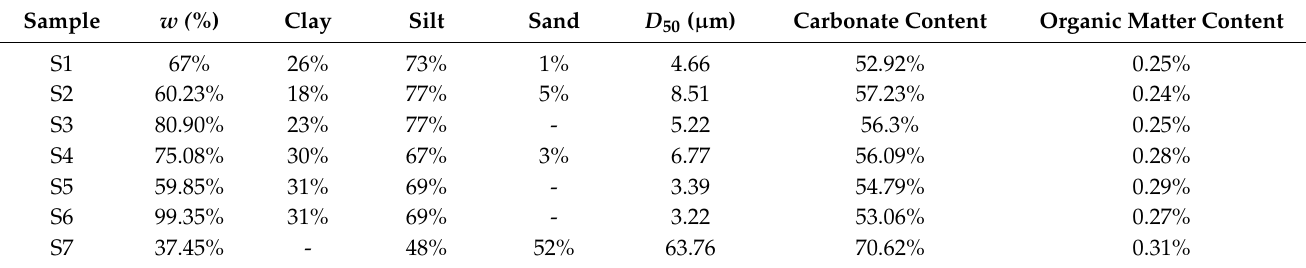
Table 3. Sediment grain-size analysis, median particle size, water content, and carbonate and organic matter content